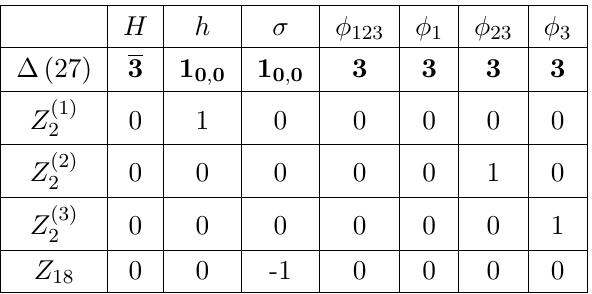
× Z (2) × Z (3) × Z 18 . Superscripts differentiate 2 2 2